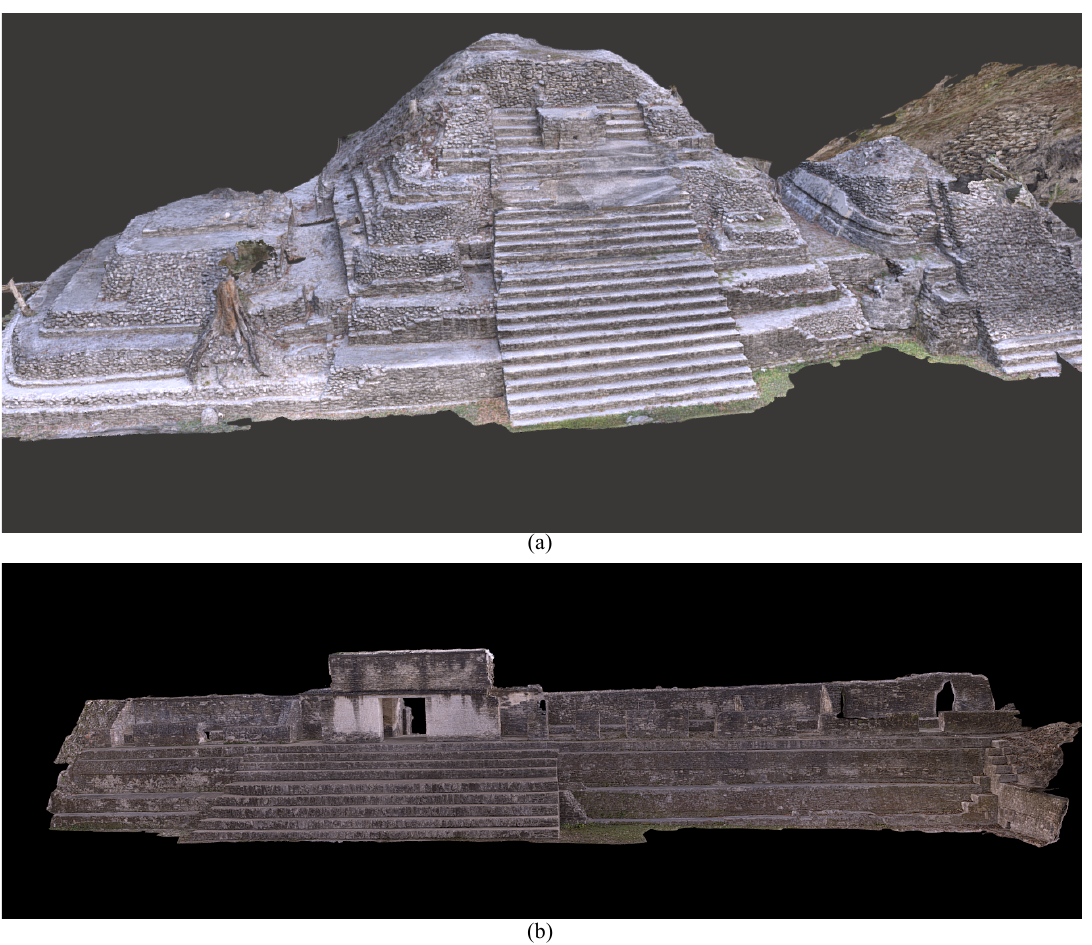
Figure 2. (a) SfM model of pyramid structures B1, B2 and B3 in Cahal Pech (main burial places). (b) SfM model of structure A2 where important ceremonies were held. More models can be found at